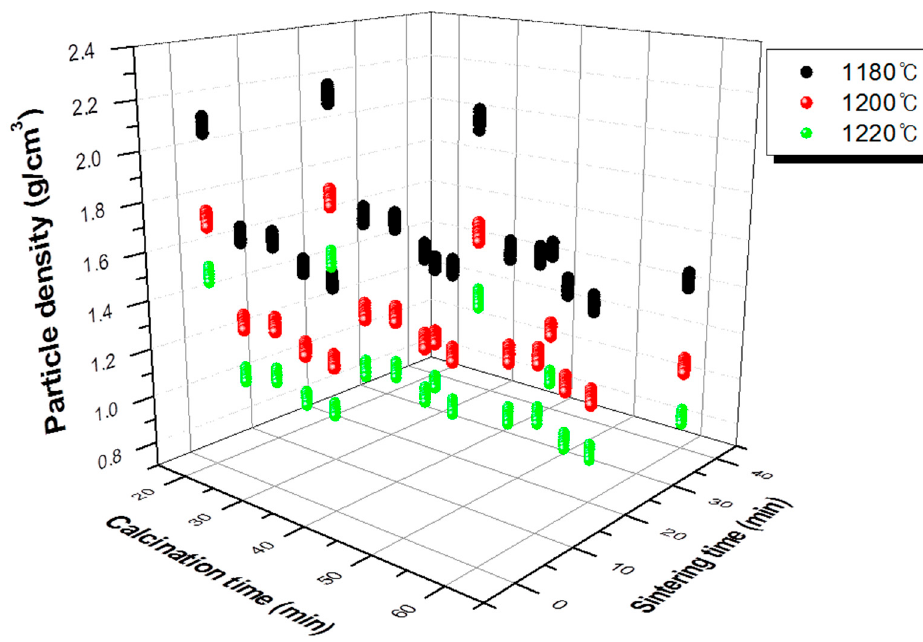
Figure 5. Expanded experiment results with the orthogonal array experiment design.